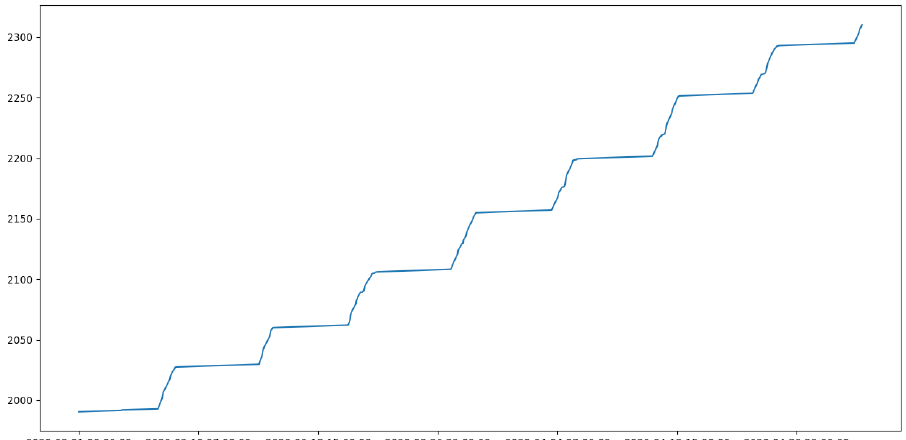
Figure 4. Power consumption data: abnormal data